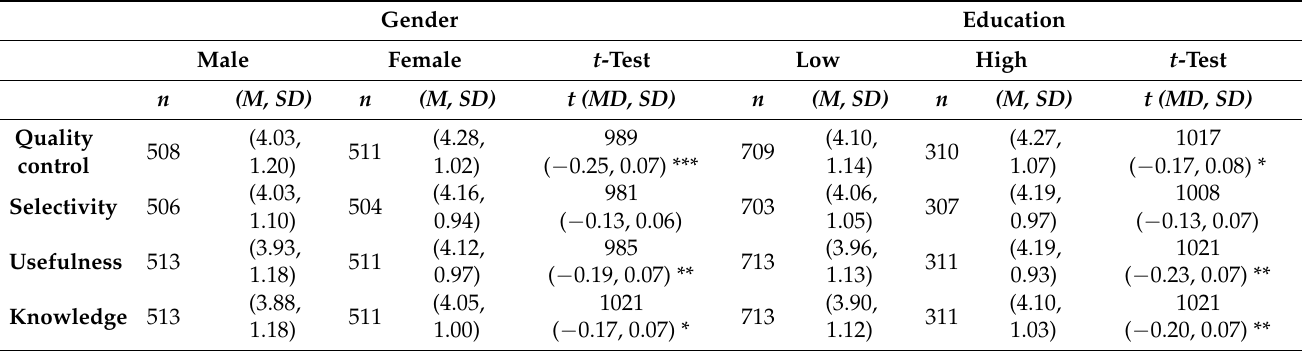
Table 2. Attitudes towards journalistic gatekeeper functions by gender and